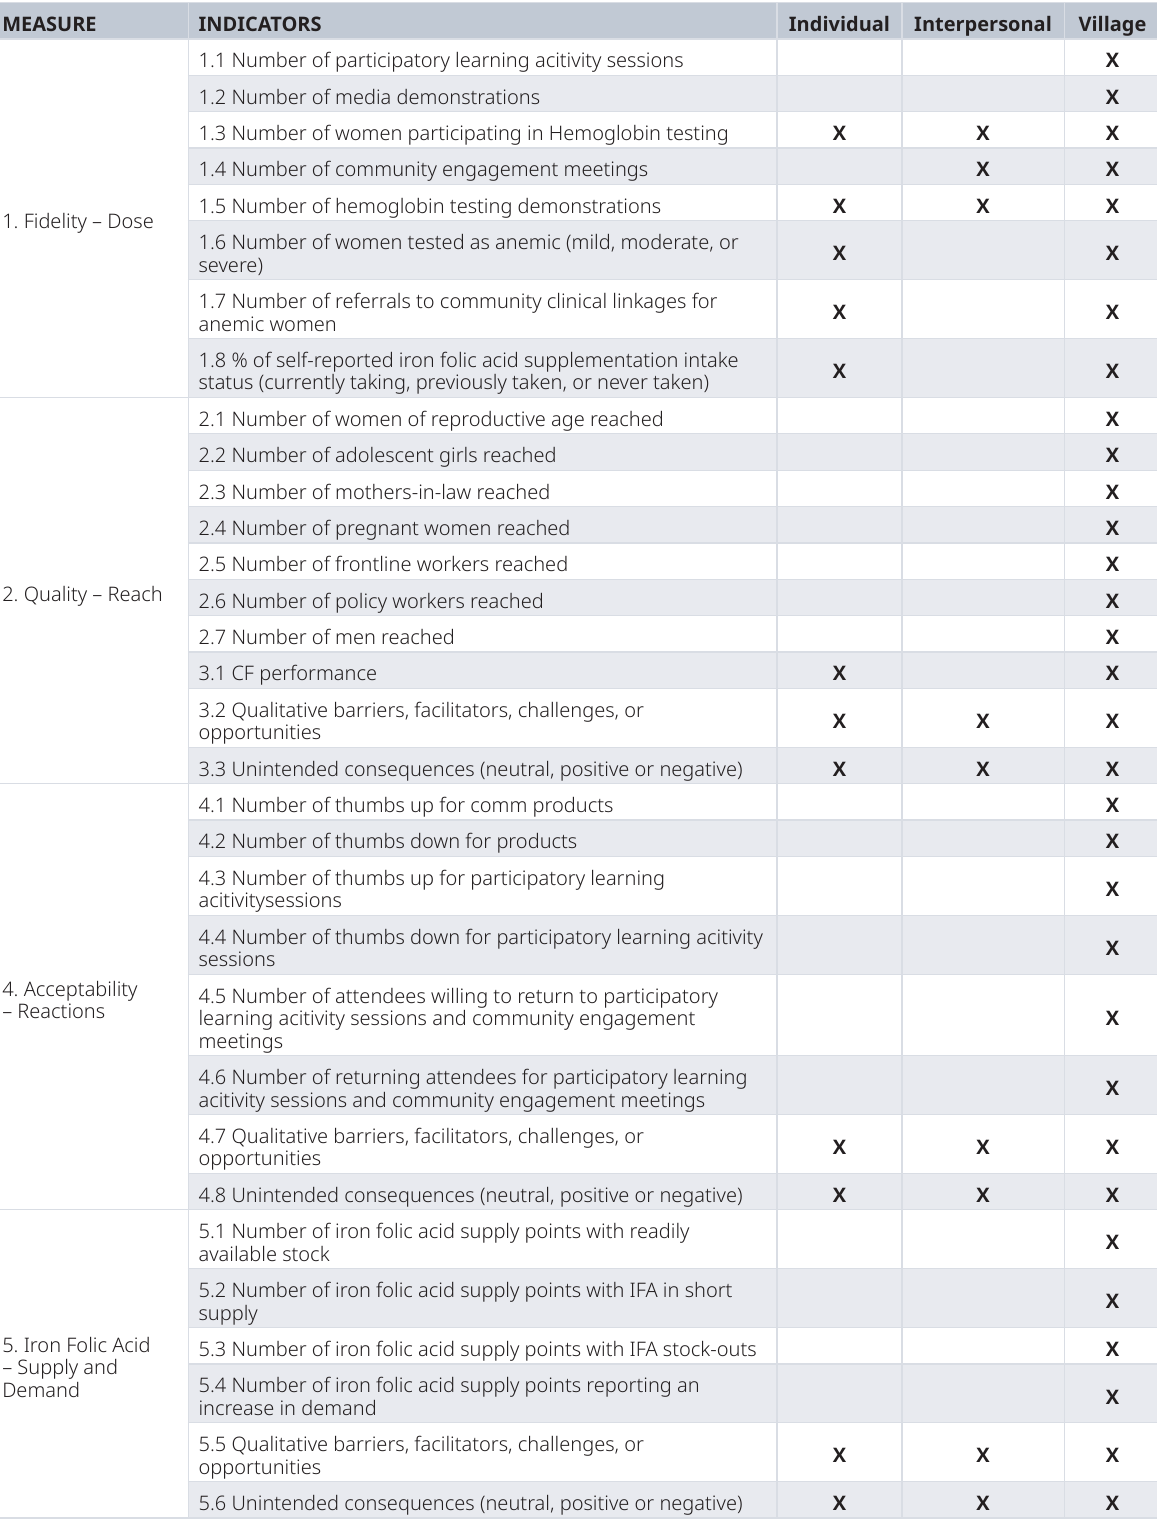
Table 2. Key performance indicators summarized at various ecological